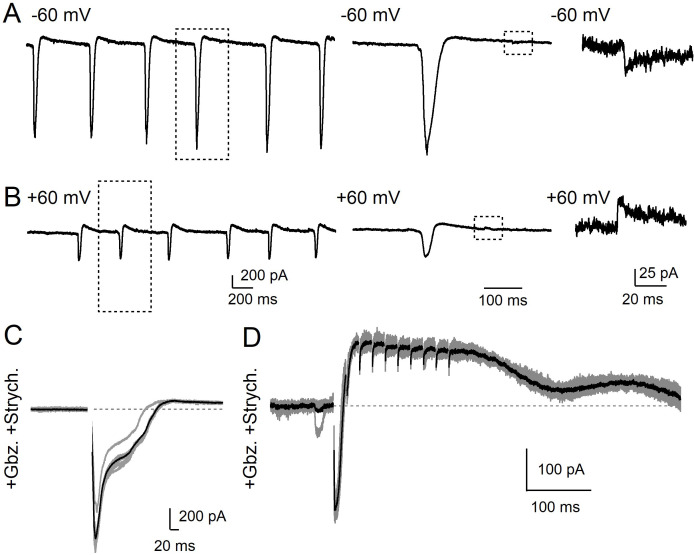
bursting and oscillation of electrically-coupled neurons in the IO can obscure synaptic responses.(A) Neurons in the IO are electrically-coupled and as a result fire and oscillate synchronously and spontaneously. Oscillations and bursting are more common at near-physiological temperature (35°C). Bursting from neighboring IO neurons can be seen in a neuron in the PIO held at −60 mV despite the presence of intracellular blockers of Na+, K+, and Ca2+ currents (by QX-314, TEA, and D-600, respectively). Bursts have waveforms distinguished by large inward currents followed by a slow outward component (middle) that reflects low-pass filtered synchronous firing of neighboring coupled neurons. Small inward synaptic events can be seen between bursts (right). Recordings were obtained at near-physiological conditions (35°C in 1.5 mM Ca2+ / 1.0 mM Mg2+). (B) Same cell as in A, but held at +60 mV. Currents generated by spontaneous electrically-coupled bursts are attenuated (Left, middle), but do not reverse. Small events between bursts mediated by chemical synapses reverse (right). (C) Current evoked by a single stimulus in a PIO neuron held at −60 mV in the presence of blockers of excitatory (NBQX, CPP) and inhibitory transmission (Gabazine, Strychnine). Evoked currents did not reverse, even when held at +60 mV (not shown). (D) Current evoked by a 50 Hz train of 10 stimuli in a PIO neuron held at −60 mV in the presence of synaptic blockers as shown in C. The train consistently initiated a burst from neighboring IO neurons, followed by a subthreshold sinusoidal oscillation that is truncated after a single phase. Evoked currents did not reverse and were not eliminated when the cell was held at +60 mV (not shown).